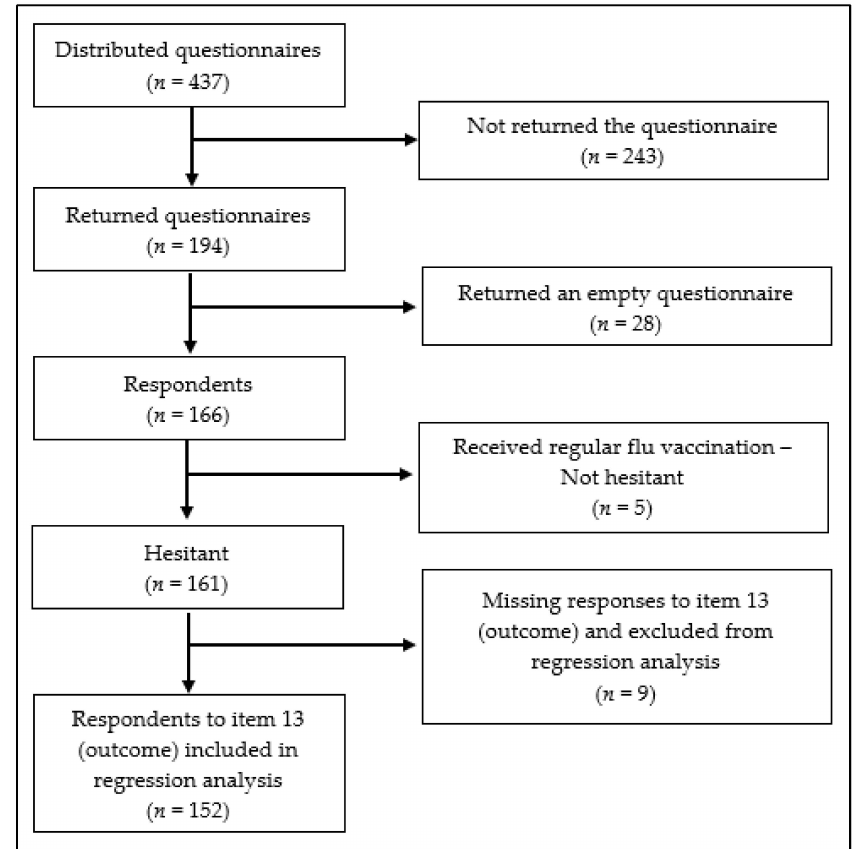
Figure 1. Flow chart of the entire recruitment